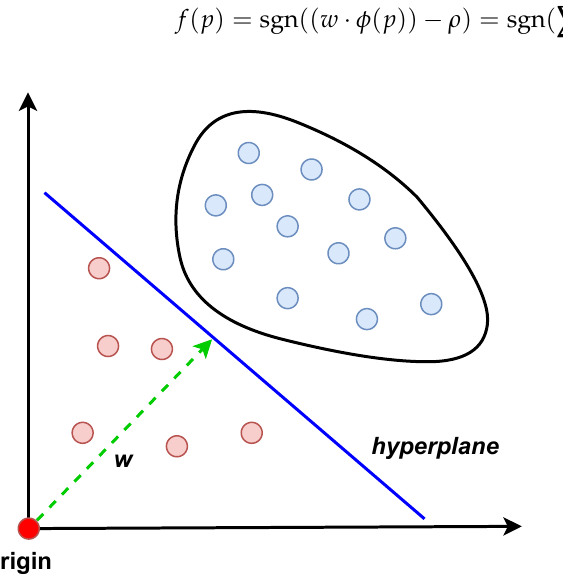
Figure 6. An illustration of